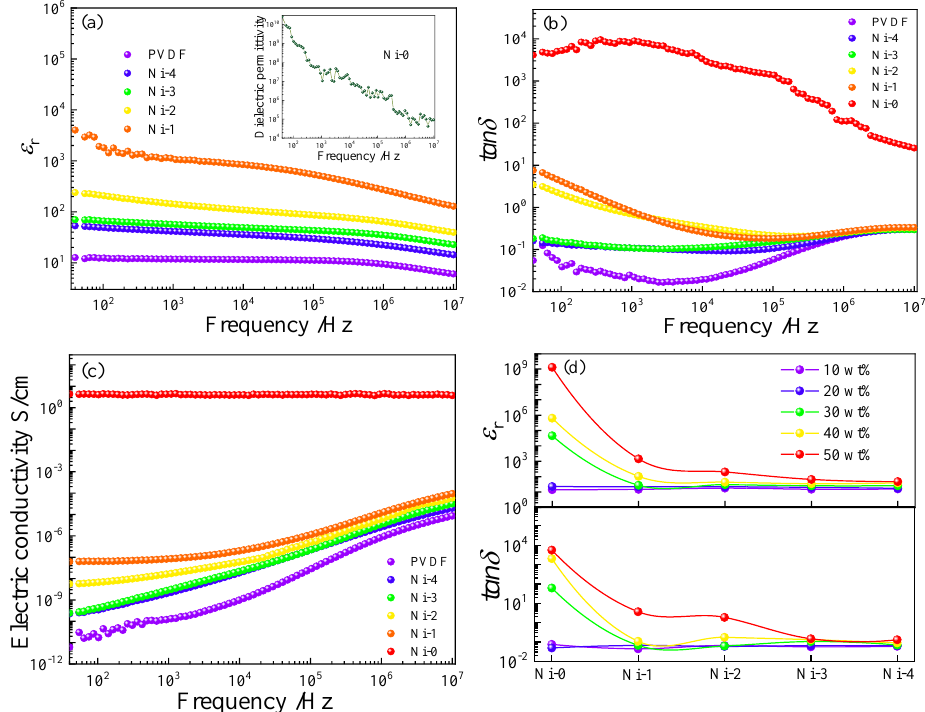
Figure 6. ( a ) ε r , ( b ) tan δ and ( c ) electric conductivity of Ni–0~Ni–4/PVDF composites with 50 wt%, the inlet standing for the Ni–0/PVDF composites, ( d ) variations of ε r and tan δ of the composites containing various fillers at different concentrations (at 10 2 Hz).